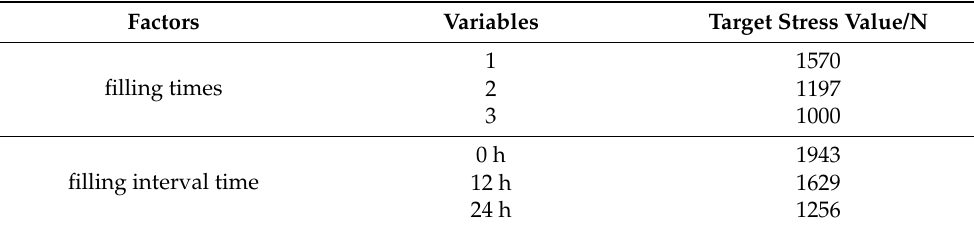
Table 1. Target stress value of the LCTB.